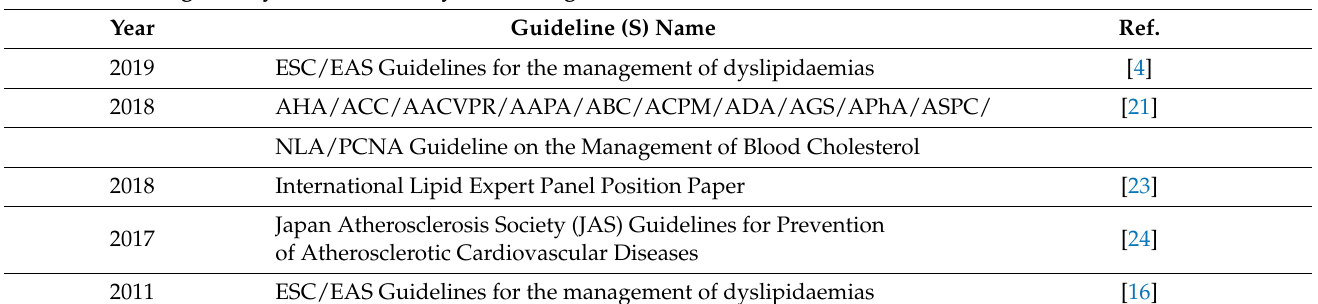
Table 1. Nutraceutical products and guidelines for